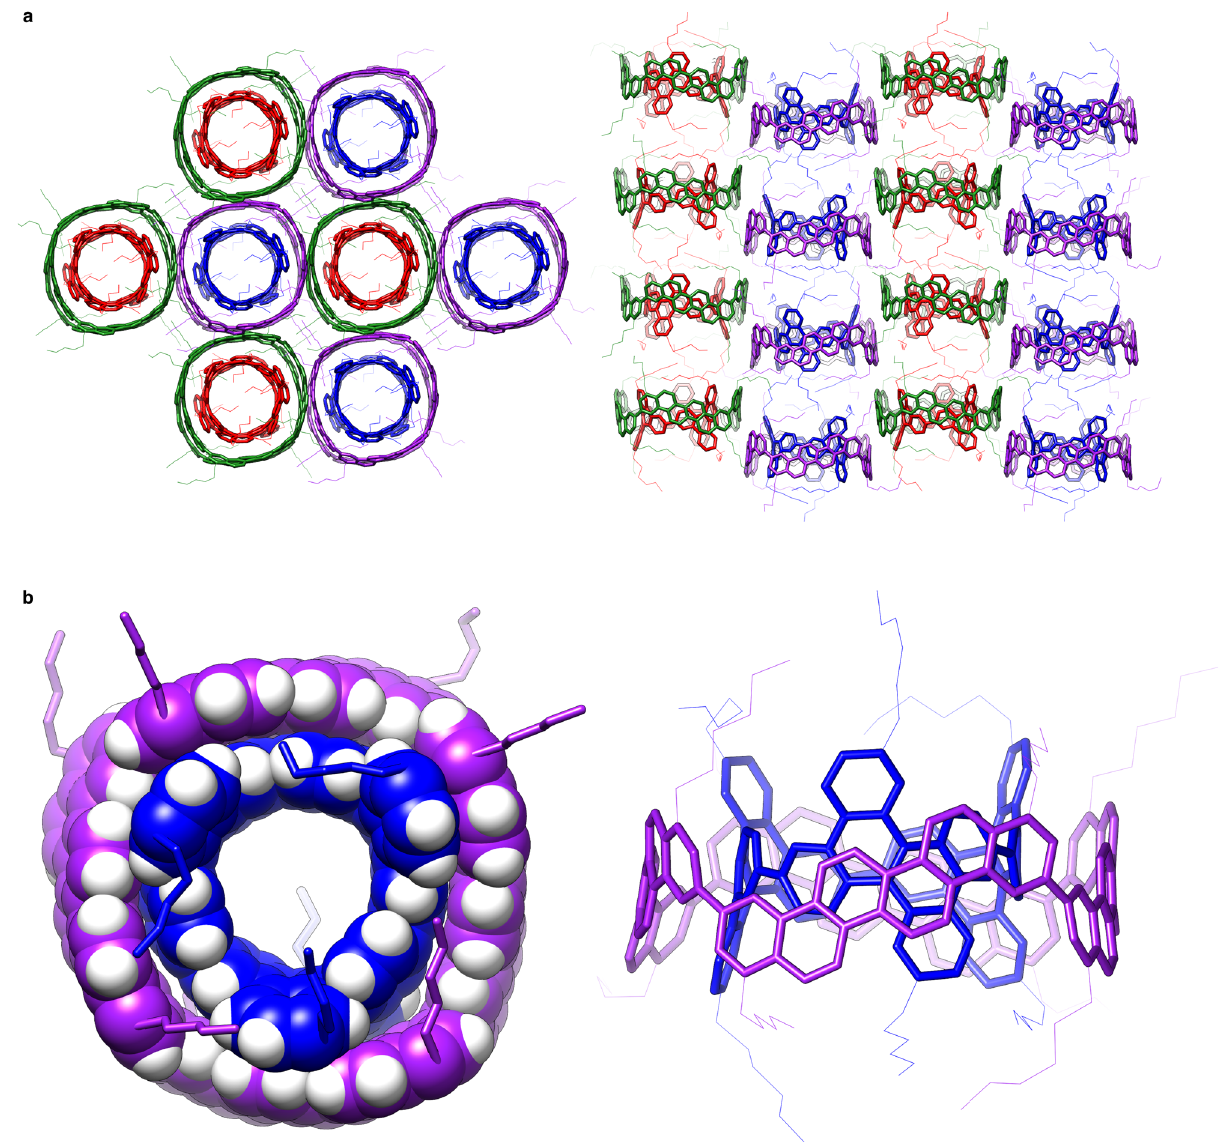
Fig. 6 Crystal structures of i-DWNT complexes. a Upon mixing four cylindrical molecules, racemates of ( P )-(20,4) ⊃ ( M )-(9,6) and ( M )-(20,4) ⊃ ( P )- (9,6) were selectively formed and assembled in a pairwise manner to fi ll the crystal space of monoclinic P 2 1 / n . b Top view and side view of the molecular structure of ( P )-(20,4) ⊃ ( M )-(9,6)